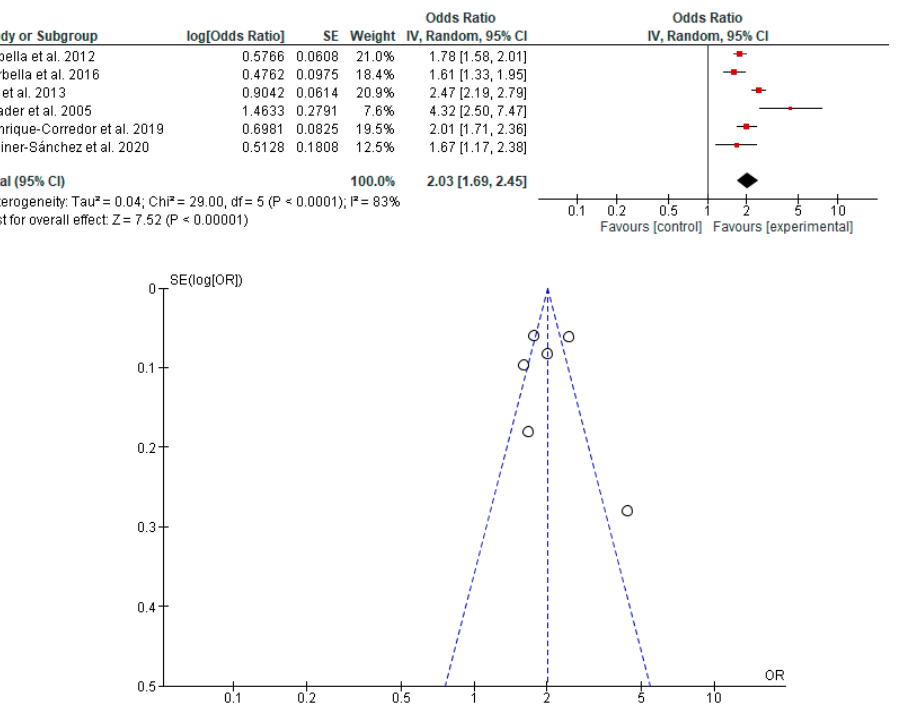
Figure 2. Forest plot and funnel plot of the association between the risk of PB in newborns with PD in pregnant women.